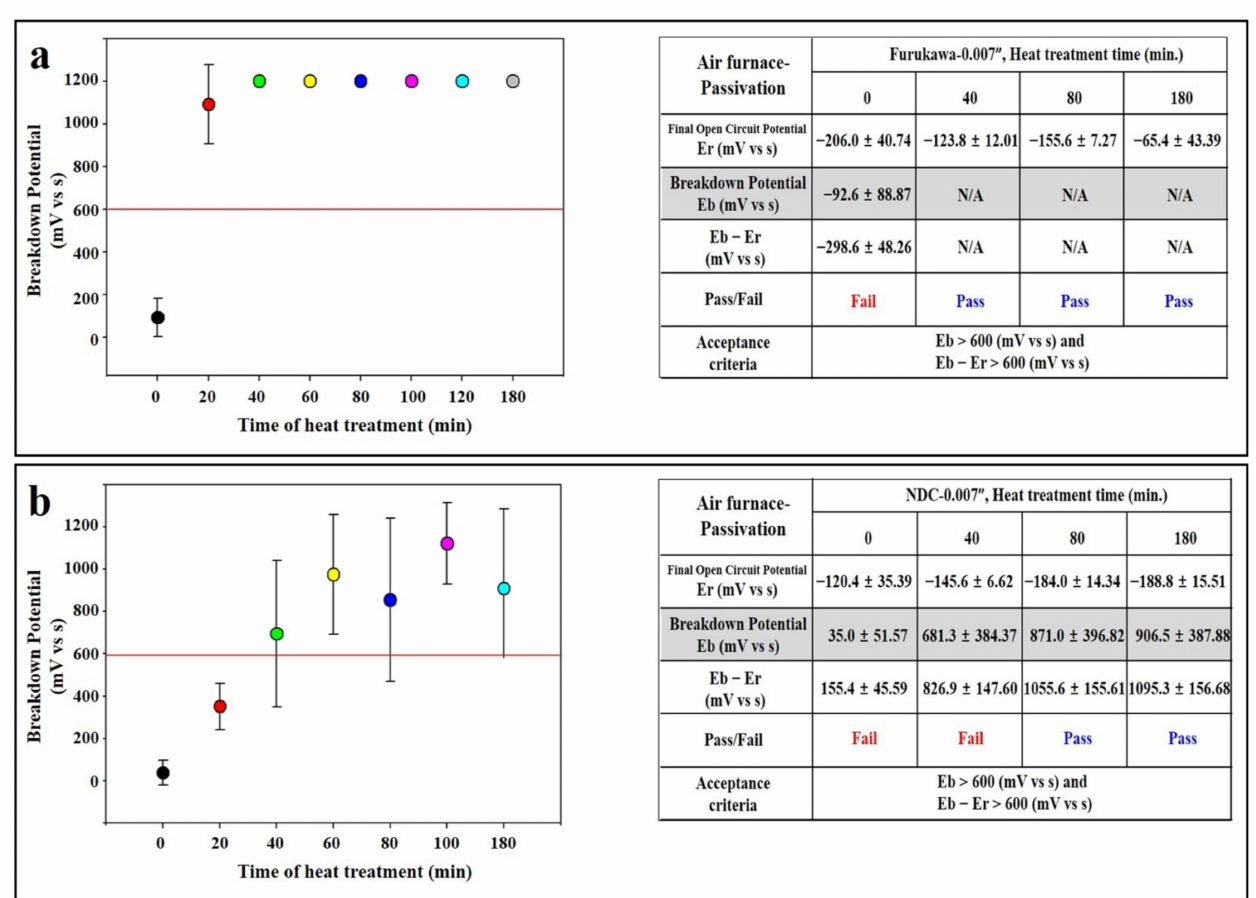
Figure 4. Passivation of wires after air furnace. ( a ) Furukawa and ( b ) NDC wire. Red lines indicate acceptance criteria in this study as mentioned in Materials and Methods section. ‘F’ and ‘N’ are acronyms for ‘Furukawa’ and ‘NDC’,